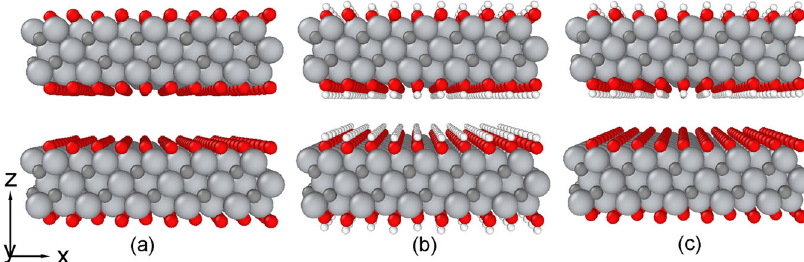
Fig. 7 MXene model overview. Atomistic models of a Ti 3 C 2 O 2 , b Ti 3 C 2 OH 2 , and c heterostructure MXenes. Atom colors correspond to: oxygen, red; carbon, dark gray; titanium, light gray; and hydrogen,